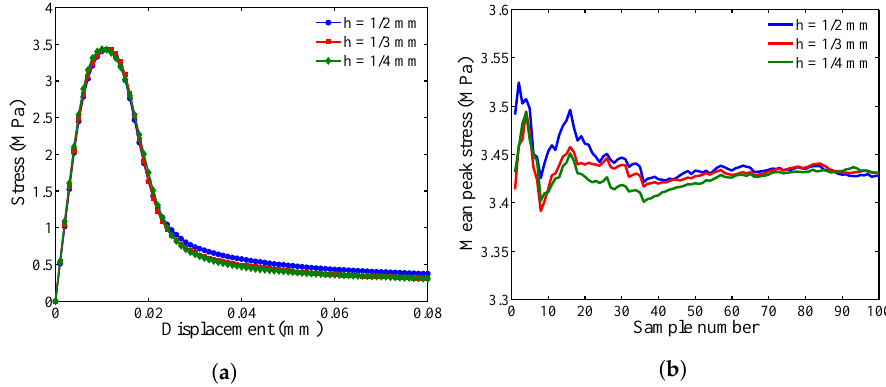
Figure 7. Effect of discretization on: ( a ) mean stress-displacement curves; and ( b ) sample number with reference to mean peak stress.